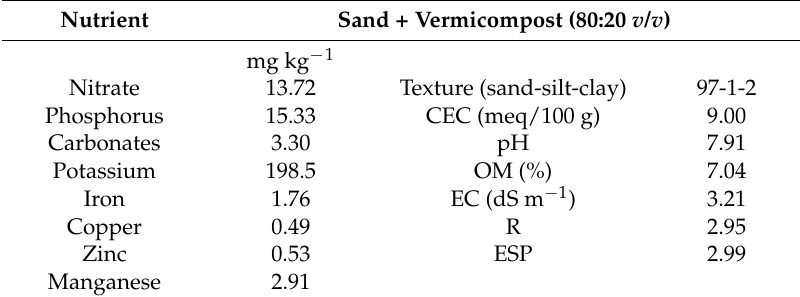
Table 2. Chemical and physical composition of the organic substrate (sand:vermicompost) used in the evaluation of algae extracts in the shade-grown cucumber